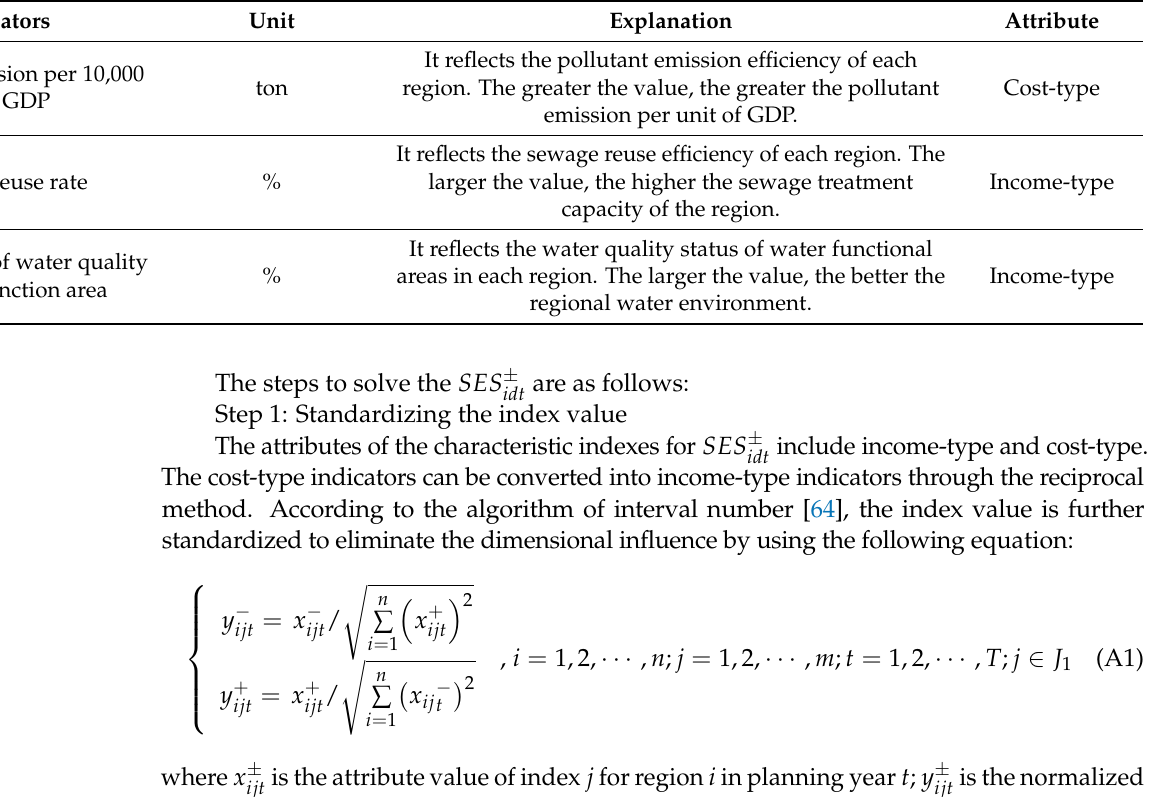
Table A1. Cont. Unit